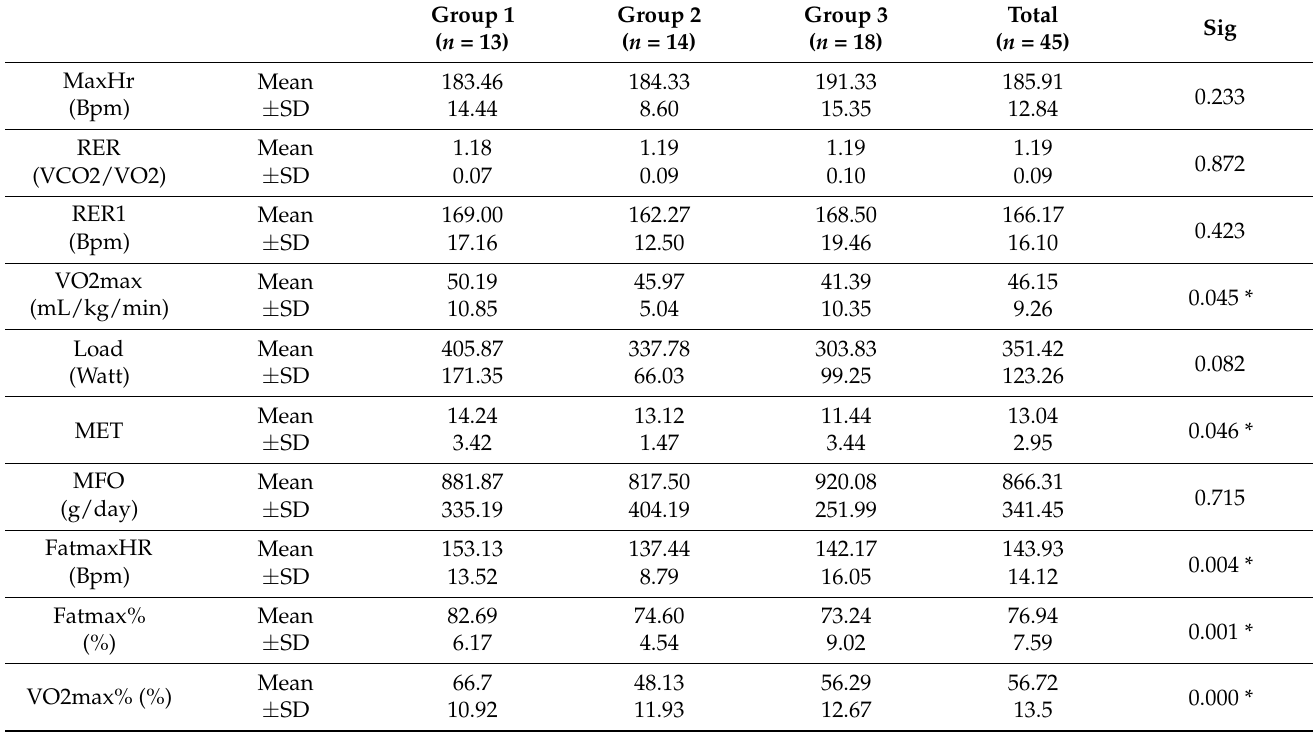
Table 2. The results of the incremental treadmill test.